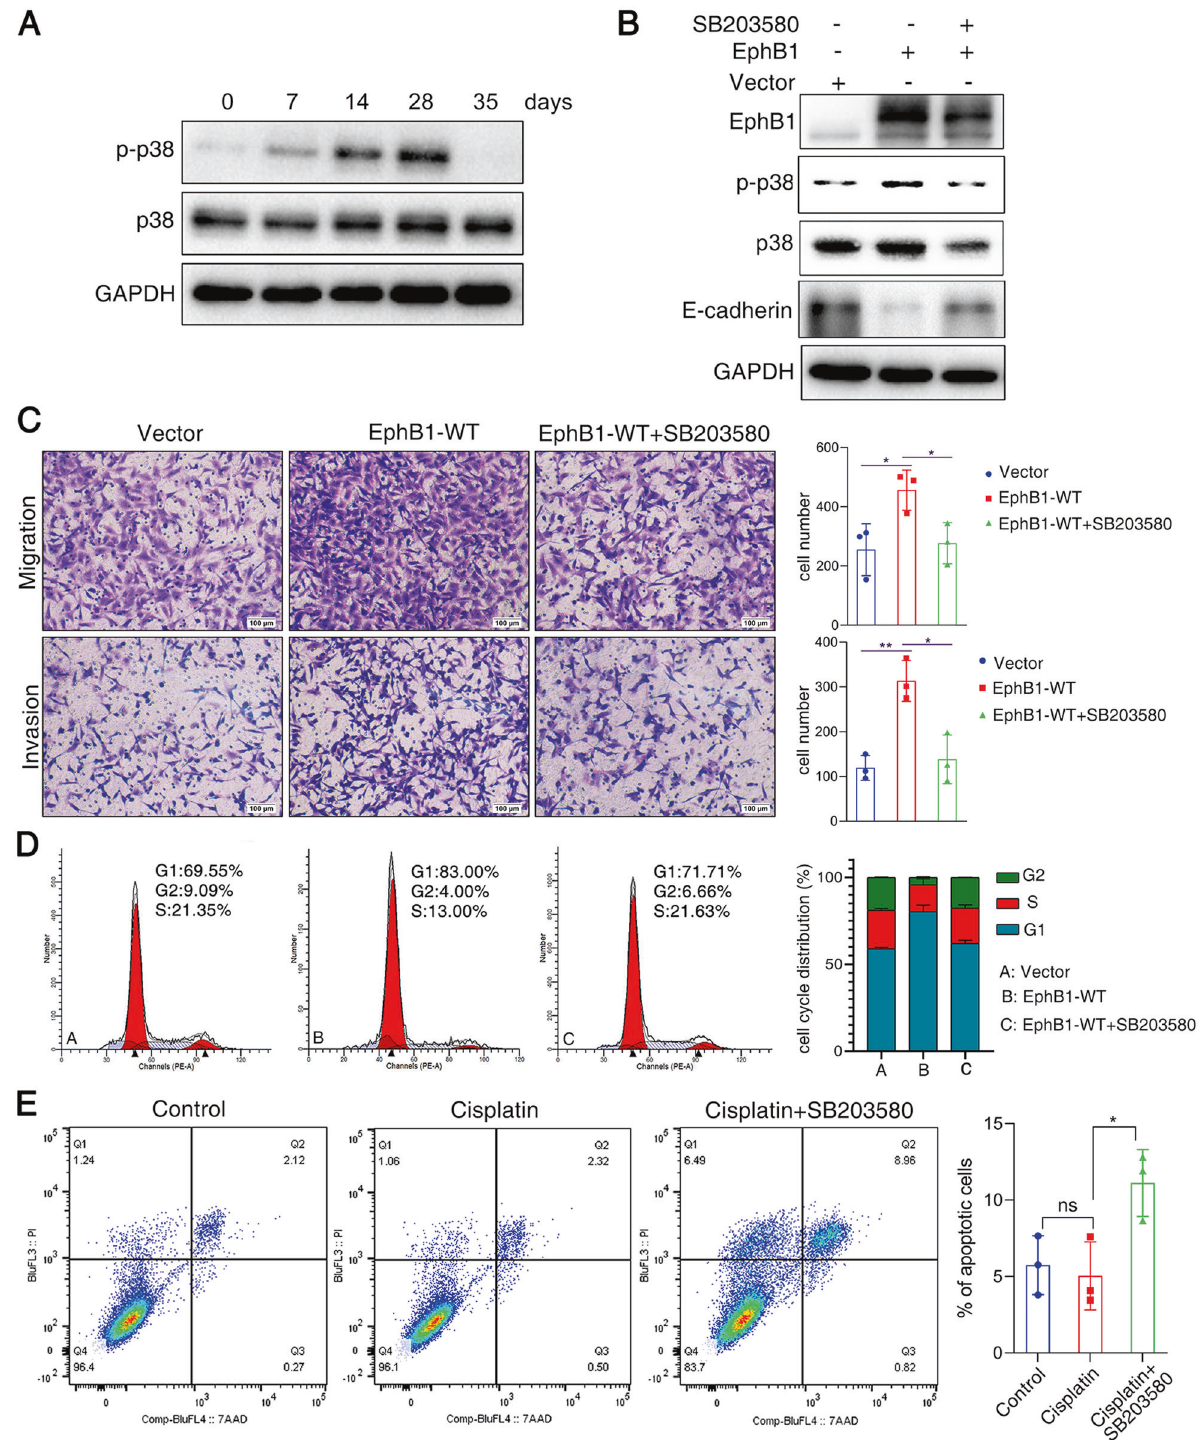
Fig. 6 Cis EphB1 signaling mediates cancer cell dormancy after chemotherapy. A Western blot analysis of p-p38 in cisplatin-treated A549 cells at different time points; B Western blot analysis of proteins obtained from EphB1 transfected cells. A549 cells were transfected with EphB1 with or without treatment of p-p38 inhibitor SB203580. C Transwell migration and invasion assays. Representative microscopic images of cells that migrated through or invated through the transwell were shown. Cells with transfected with EphB1 with or without treatment of p-p38 inhibitor SB203580. The histogram graph was shown on the right. Data are presented as the mean ± S.D. from at least three separate experiments. Student ’ s t test, * P value < 0.05, ** P value < 0.01; Scale bar = 100 μ m; D Cell cycle analysis; E Flow cytometry analysis of apoptotic cells after treatment of cisplatin combined with p-p38 inhibitor. Representative fl ow cytometry plots using Annexin V-FITC/PI staining for apoptosis. The percentage of apoptotic cells were shown on the right. Data are presented as the mean ± S.D. from at least three separate experiments. Student ’ s t test, * P value < 0.05, ** P value < 0.01.